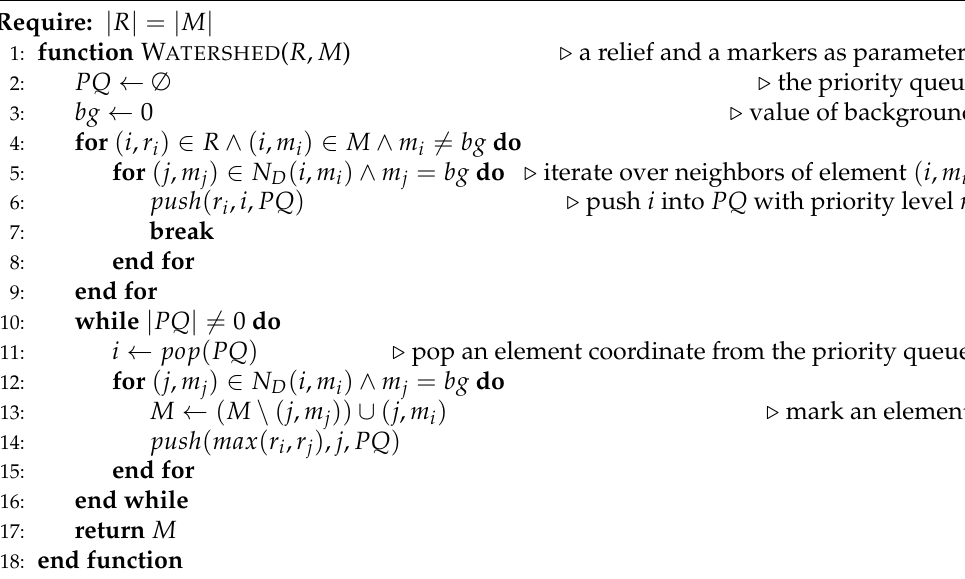
Algorithm 1 The marker-controlled watershed by Beucher and Meyer [25].